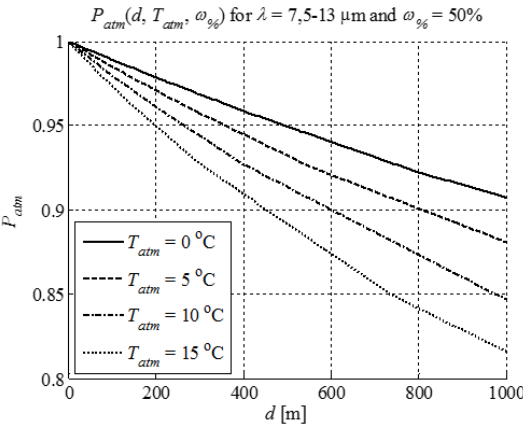
Table 2. A part of the Passman–Larmore table for carbon diox- ide absorbance P CO